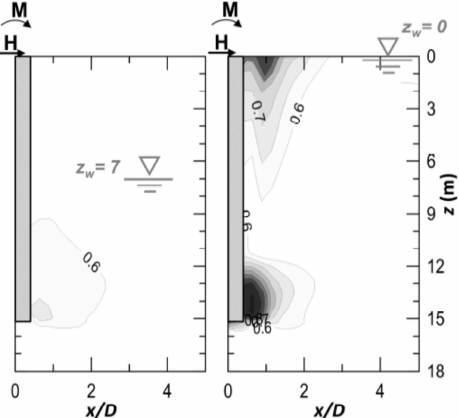
Figure 9. Shear strength mobilisation for H = 0.4 MN in the loose soil analyses.